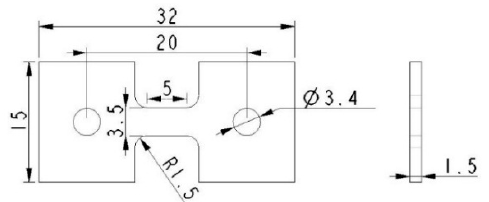
Figure 3. Shape and dimension of tensile specimen.